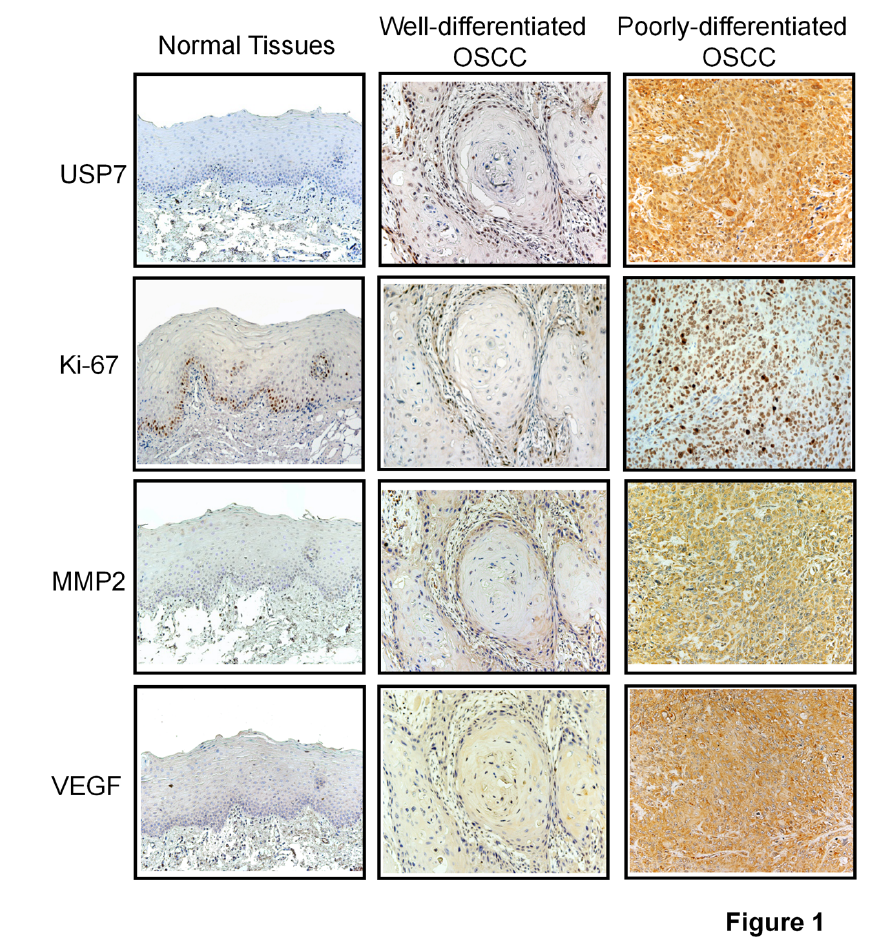
Figure 1 – Expression of USP7, Ki-67, MMP2 and VEGF were elevated in OSCC tissues. Staining antibodies against human USP7, Ki-67, MMP2 and VEGF to show relative protein expression in normal tissues, well-differentiated OSCC and poorly-differentiated OSCC tissues. Image magnification is 200